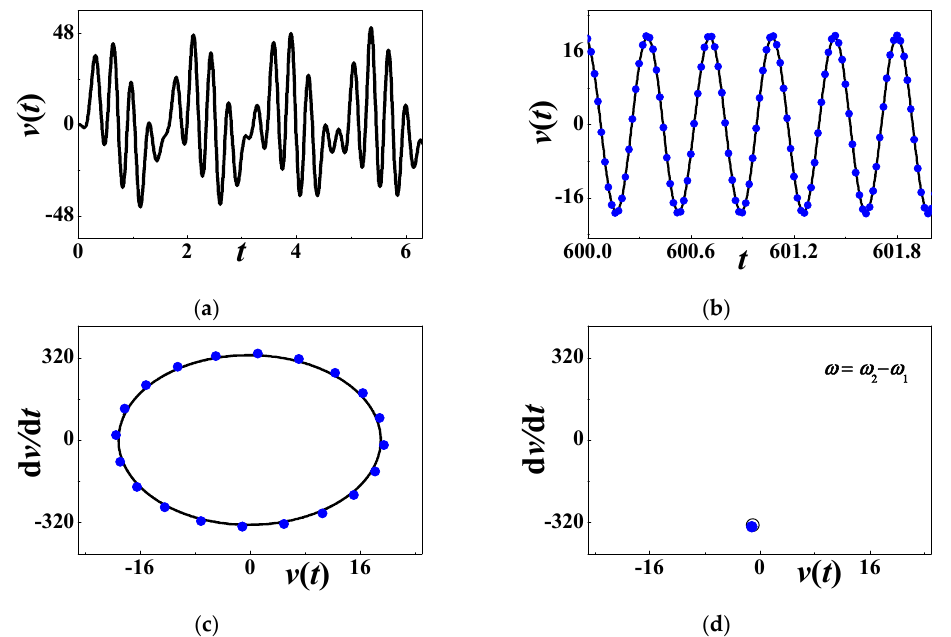
Figure 5. The small-amplitude periodic response when ω = ω 2 − ω 1 : ( a ) initial history; ( b ) steady-state response; ( c ) phase diagram; ( d ) Poincare map. The solid blue dots stand for analytical prediction and others for numerical simulation.